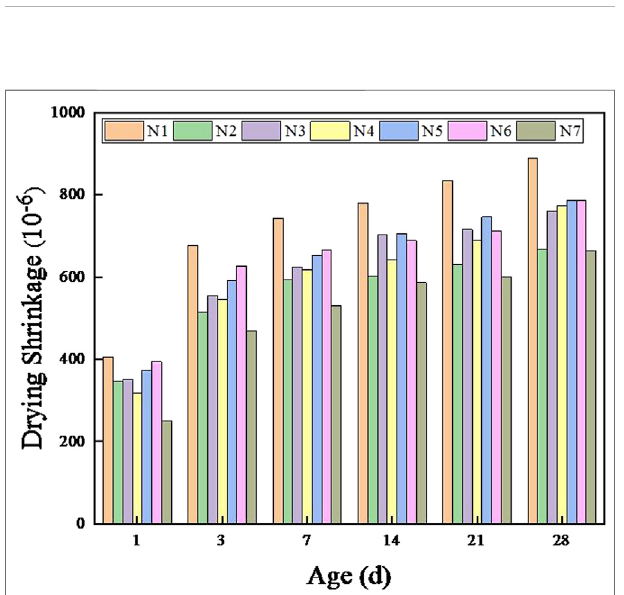
FIGURE 4 | Effect of M-PCE on drying shrinkage of UHPC.